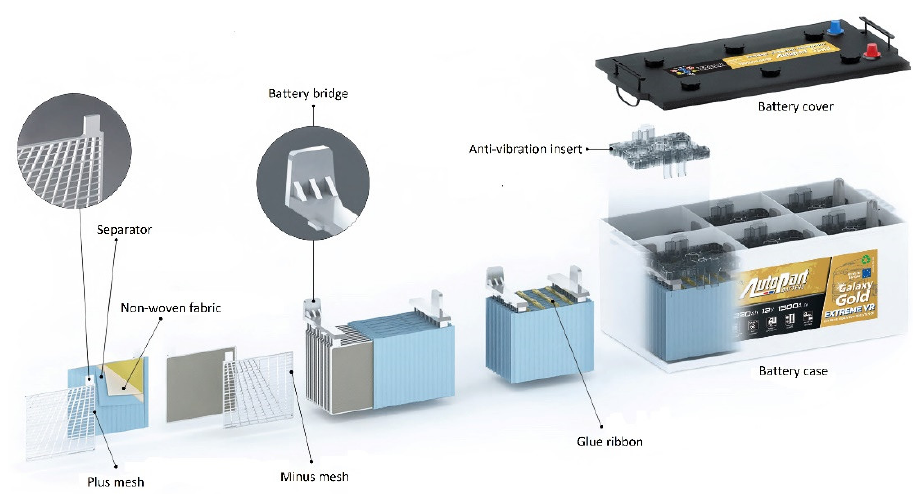
Figure 1. Battery construction diagram (produced by AUTOPART-Mielec, Poland).